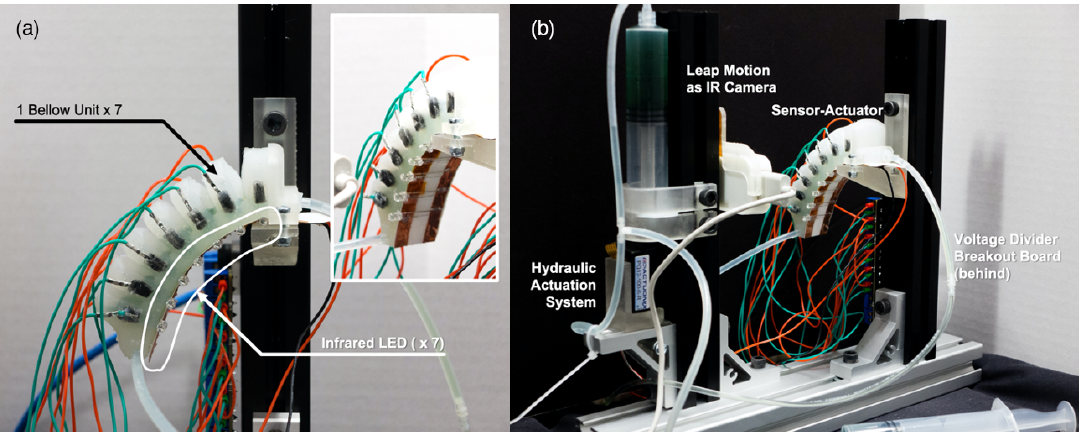
Figure 1. ( a ): Our soft robotic sensor–actuator in its idle pose. Shown in the inset are the seven infrared LEDs on a copper strip attached to the actuator, which also acts as a strain-limiting layer. ( b ): The experimental setup with the hydraulic actuation system is shown, along with the Leap Motion infrared camera and breakout board for data